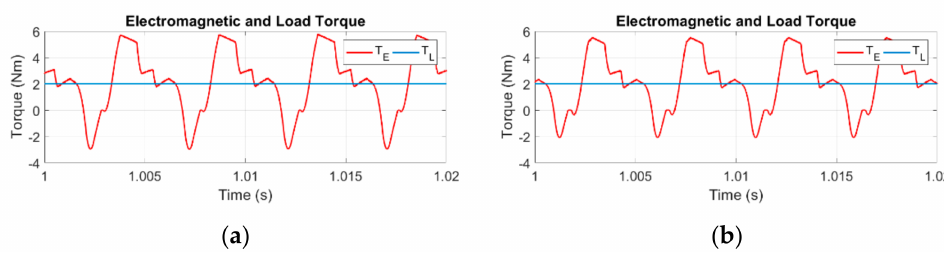
Figure 10. Electromagnetic torque T E compared to the load torque T L in case of rated speed and load under Hall-effect position sensor A breakdown fault: ( a ) Defective sensor A at high state, ( b ) Defective sensor A at low